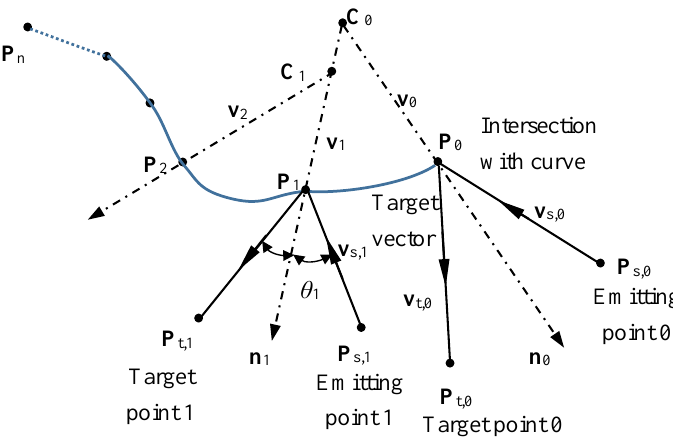
Figure 4. Generating free-form curve using CGCM [19]. The free-form curve is generated based on the whole discrete points. More intensive points obtain higher precision but also more simulation cost for ray tracing. With different points quantity, Figure 5 collected the ray intersections on TR and PVR based on B-spline curve generated by CGCM, and compared them with the preset and accurate target points, through which the accuracy verifications of 10, 30, and 50 points have been conducted. In the figures, lower-sequence points on the left half are used for thermal heat transfer and higher-sequence points on the right half are used for PV conversion. The model aims to collect maximum power at the TR part so the target points are all fixed in original point. It can be seen that, with the increase in points quantity, the constructed model has become more accurate. By considering both precision and simulation cost, 50 discrete points were chosen and generated for the single curve that will be rotated around the central axis for a real free-form surface. The ray tracing technology is then used for the estimation of optical characteristic of TFSC.